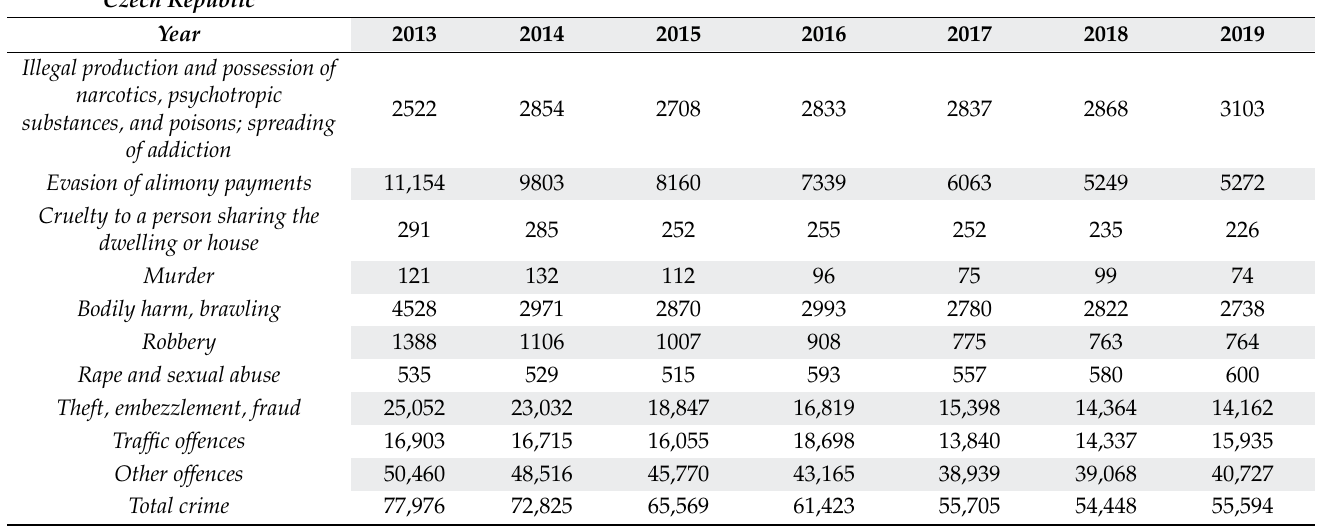
Table 3. Crime statistics on the major offences committed in the Czech Republic (Source: Statisti- cal metainformation system [49] Hungary (https://bsr.bm.hu/Document, B˝uncselekm é nyi adatok databases, accessed on 20 December 2012 [49]; the translation of each Hungarian crime type